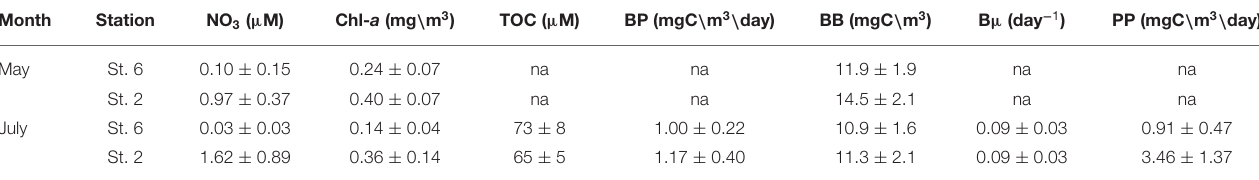
TABLE 2 | The euphotic zone (0–100m) depth-integrated averages ± SDs of the measurements collected from stations 6 and 2 of the May and July cruises.